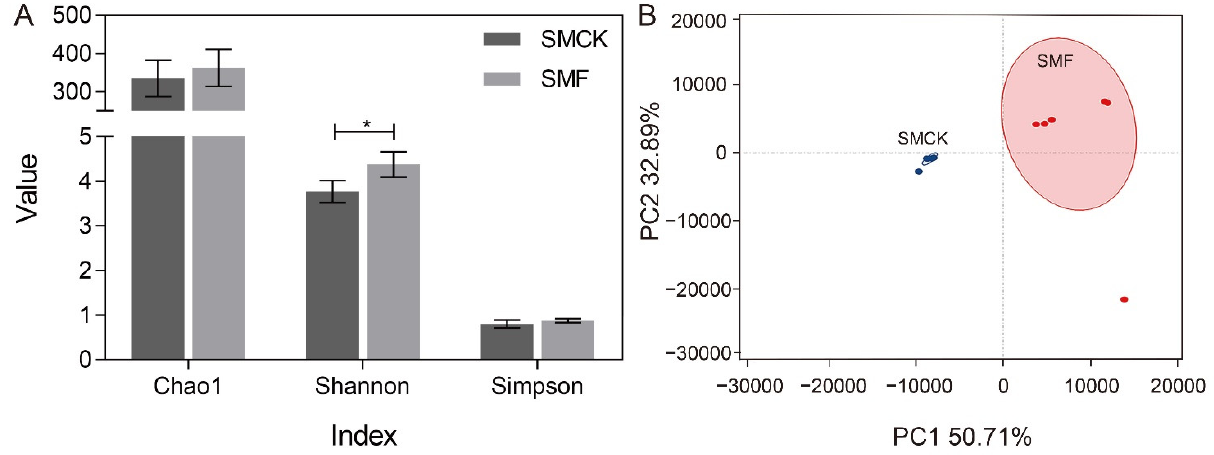
Figure 2. The diversity analysis of microbiota communities after 24 h fermentation. ( A ) Alpha diversity indices (Chao1, Shannon, and Simpson), ( B ) PCA plot. Chao 1 index indicated the community richness, Shannon and Simpson index indicated the community diversity in samples. The significantly different results were indicated by specific symbols (*, p < 0.05).